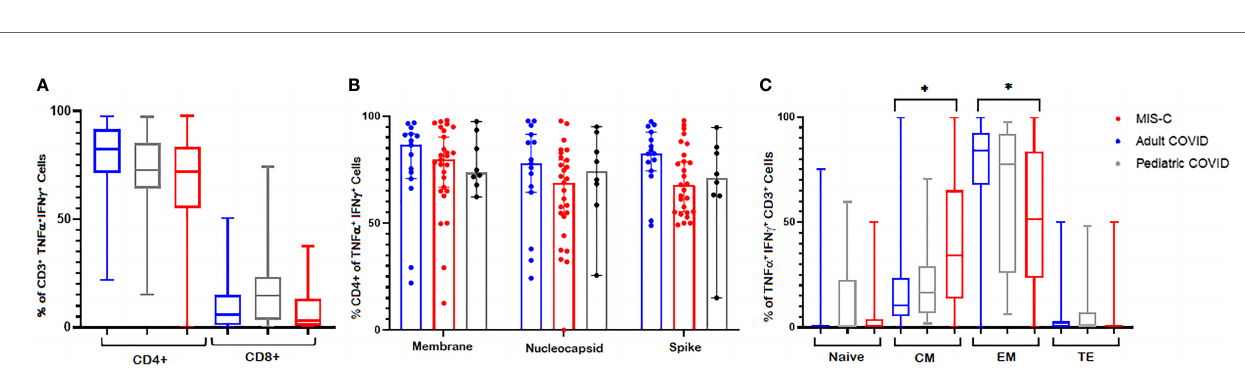
FIGURE 5 | CST Phenotypes. CSTs were predominantly CD4+ across (A) cohorts and (B) SARS-CoV-2 antigens. (C) CSTs expanded from patients with MIS-C had fewer effector memory and more central memory cells than CSTs from convalescent adults ( p < 0.0001). In (A, C) Boxes represent interquartile ranges; lines: median values; whiskers: minimum to maximum. In (B) Boxes represent medians; whiskers: 95% con fi dence interval. EM, effector memory; CM, central memory; TE, terminal effector. Asterisk (*) signi fi es p < 0.05.